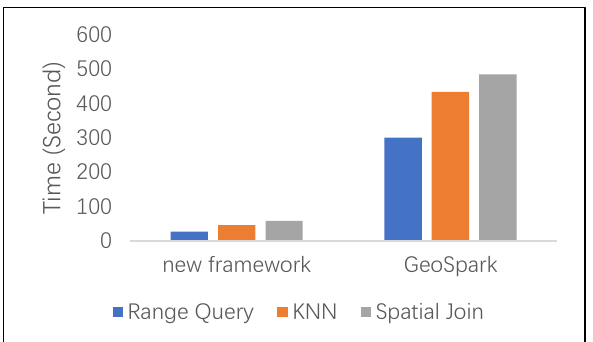
Figure 4. Spatial join experiments with different frameworks and data